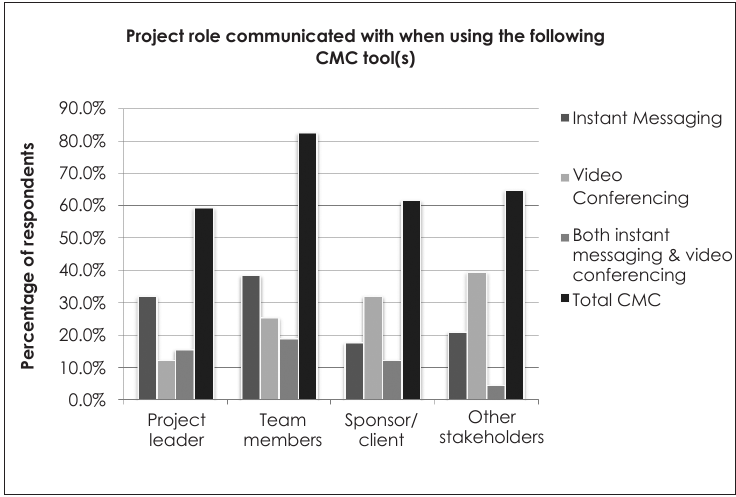
Figure 2: Recipients of CMC communication in